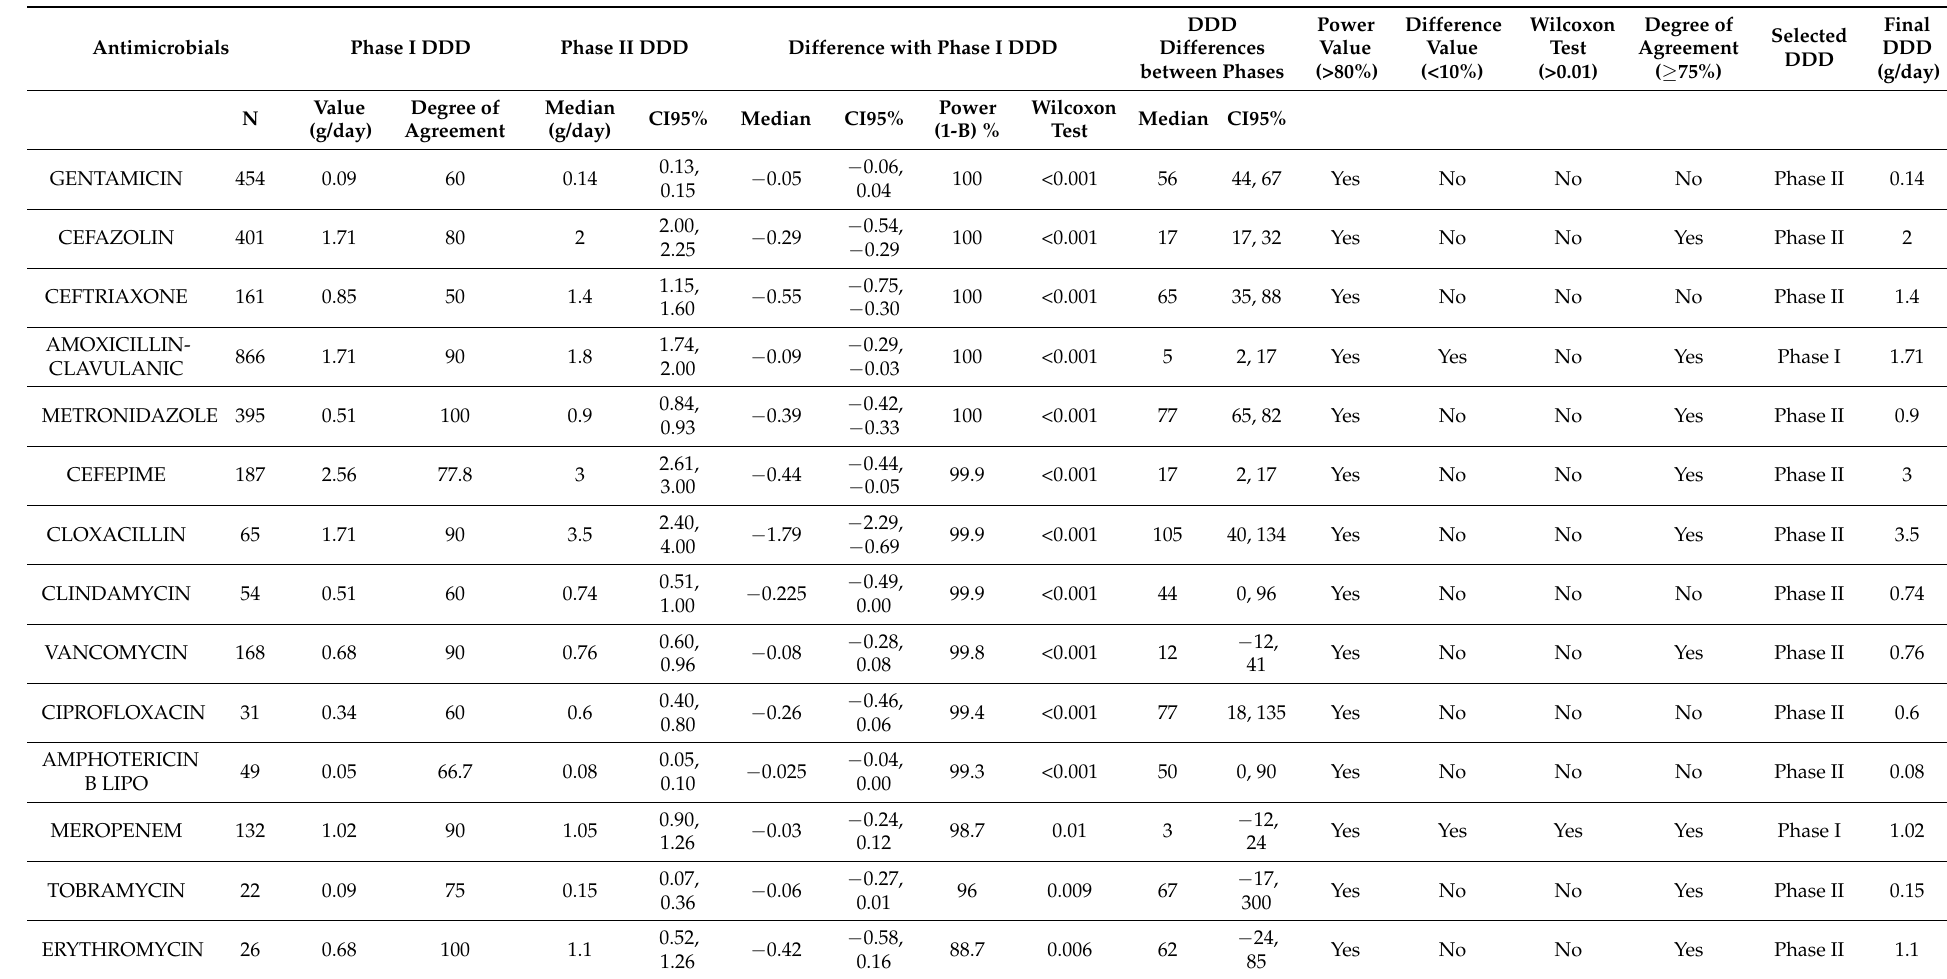
Table 3. Pediatric-defined daily doses of intravenously administered antimicrobials according to the results of data analysis.